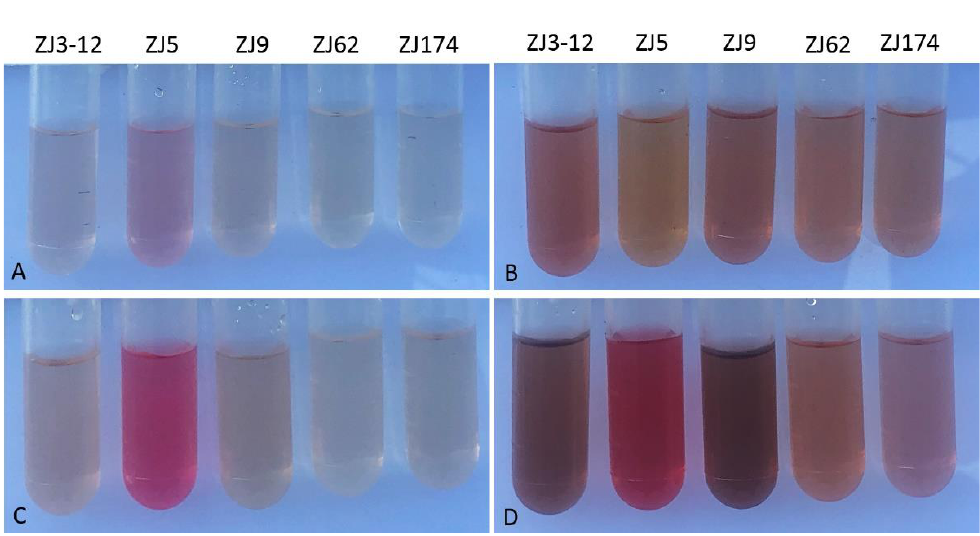
Figure 4. The IAA production of five strains at different pH was determined by observing the development of a pink-red color after adding 10 µ L bacterial resuspension to test tube containing 5 mL nutrient broth with 0.1% tryptophan, mixing 1 mL of supernatant from each test tube with 4 mL Salkowski’s reagent, and incubating the test tubes at room temperature for 30 min in the dark. Bacterial suspension was prepared by incubating bacteria in nutrient broth at 180 rpm at 30 ◦ C for 20 h and then adjusting the density of cells to 10 7 cfu/mL. ( A ). without tryptophan at pH 5.0. ( B ). 0.1% tryptophan at pH 5.0. ( C ). without tryptophan at pH 7.0. ( D ). 0.1% tryptophan at pH 7.0.